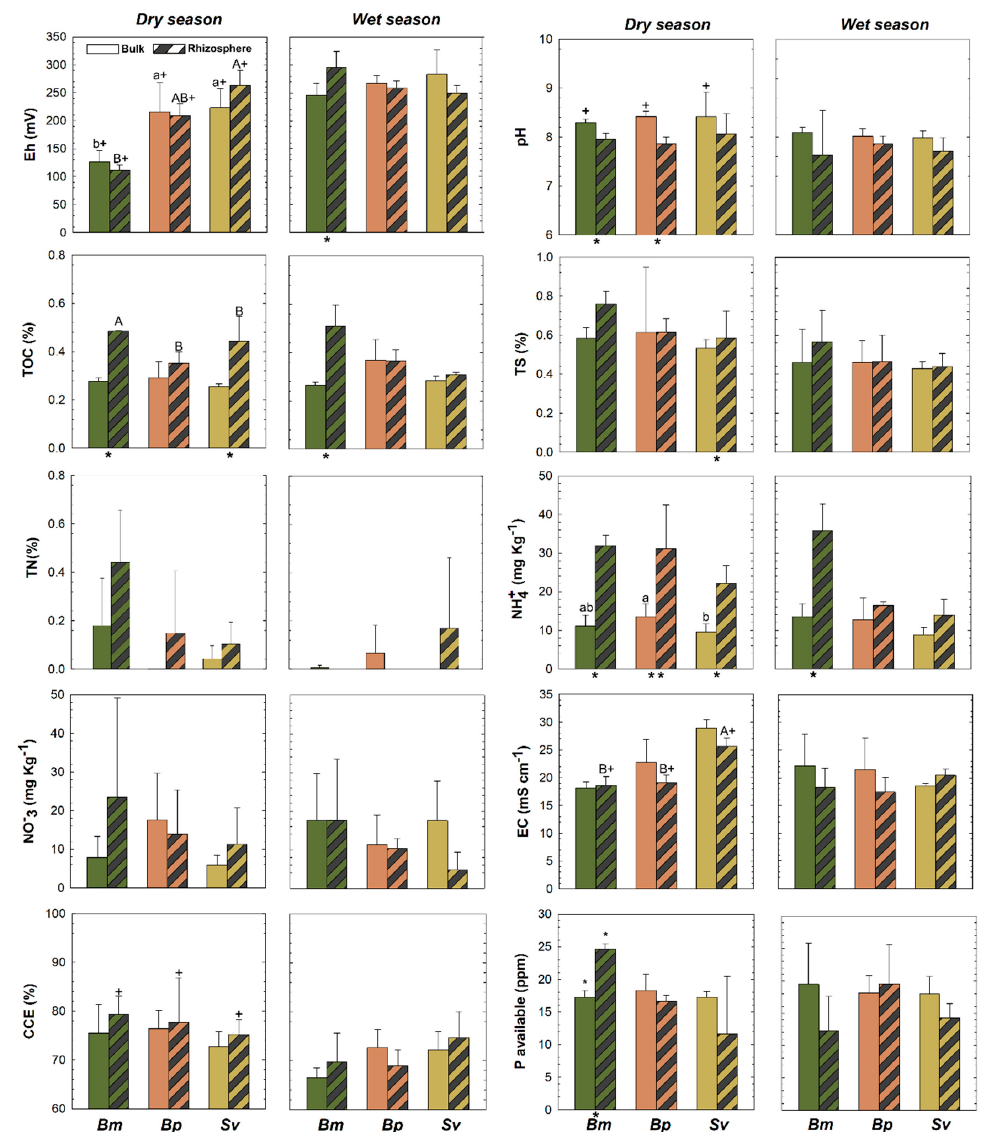
Figure 3. Soil properties for rhizosphere and bulk soils for Batis maritima (Bm), Blutaparon portulacoides (Bp), and Sporobolus virginicus (Sv) contrasted between dry and wet seasons in the hypersaline tidal flat. TOC: Total Organic Carbon, TN: Total Nitrogen, TS: Total Sulfur, EC: Electric Conductivity, and ESP: Exchangeable Sodium Potential. Di ff erent lowercase letters indicate significant di ff erences at the 5% probability among di ff erent plants in the bulk soils. Di ff erent uppercase letters indicate significant di ff erences at the 5% probability among di ff erent plants in the rhizospheric soils. The symbol (*) represents significant di ff erence ( p < 0.05) between bulk and rhizospheric soil for each plant and season. The symbol ( + ) represents significant seasonal variation ( p < 0.05) comparing bulk and rhizospheric soils for each plant species. The absence of the symbols (lowercase letters, uppercase letters, + and *) represents no statistically significant di ff erence between the studied